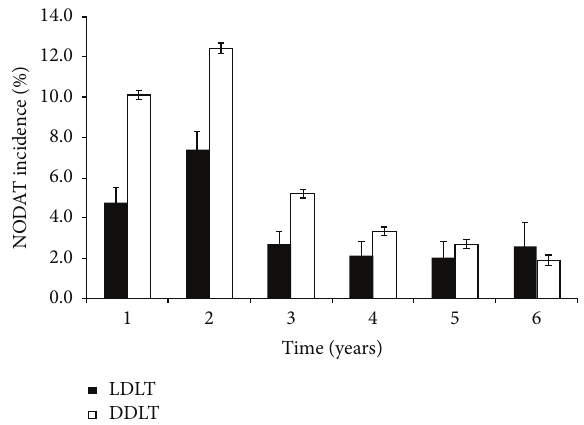
Figure 1: Incidence of NODAT in LDLT and DDLT recipients over